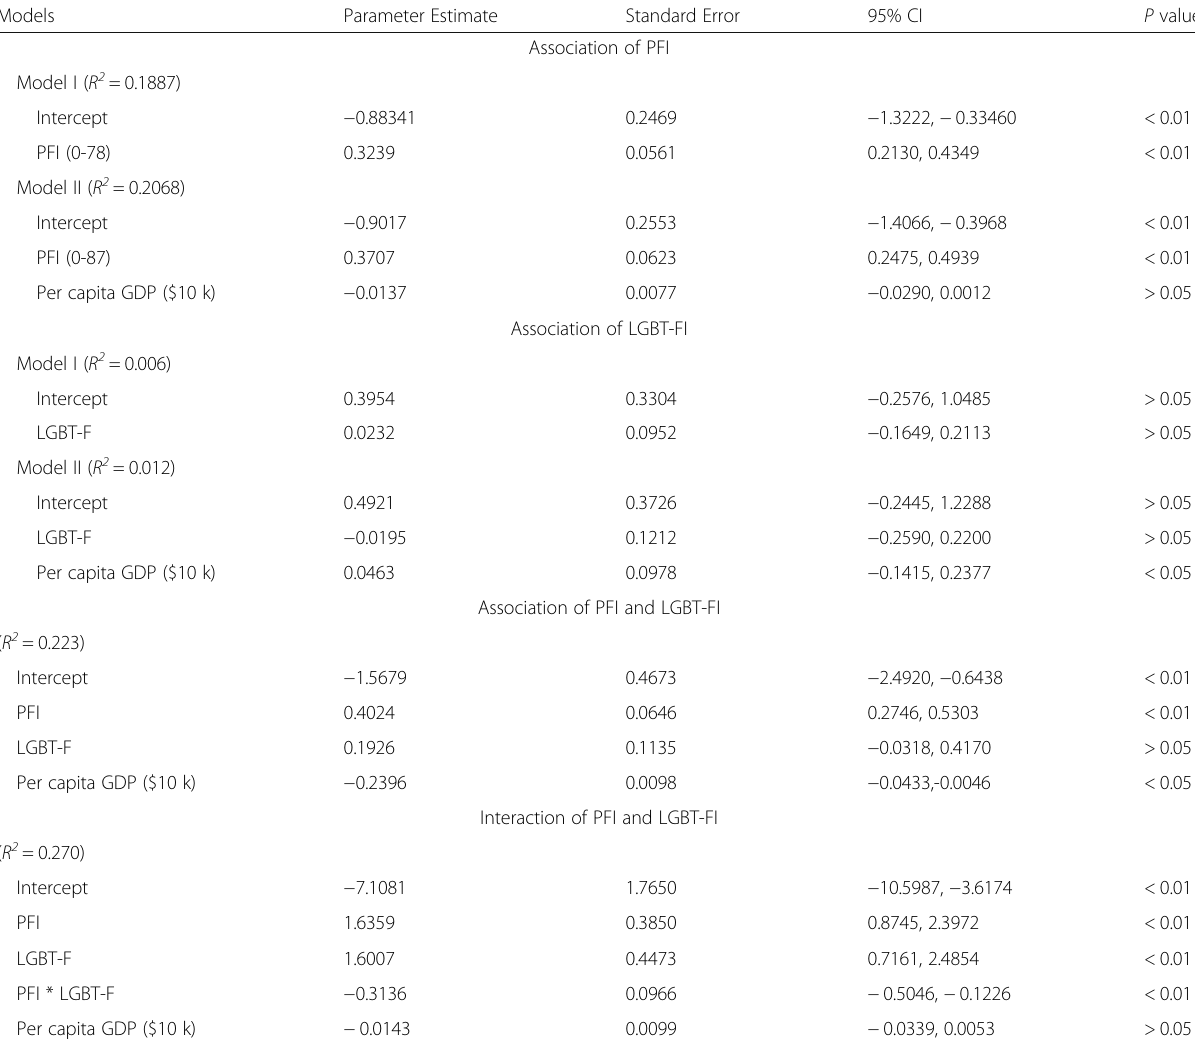
Table 1 Results from multiple regression using the Press Freedom Index to predict the prevalence rates of persons living with HIV in countries across the globe Models